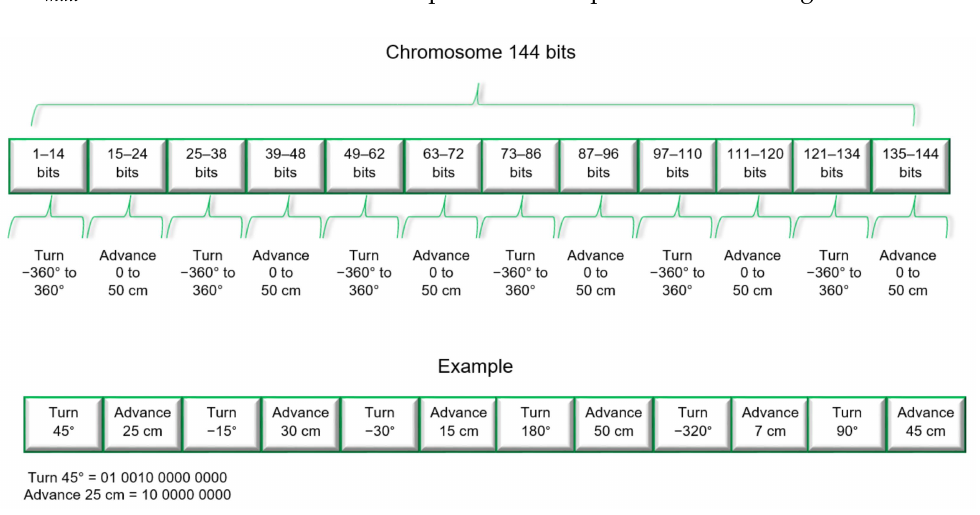
Figure 4. Chromosome-to-motion conversion.